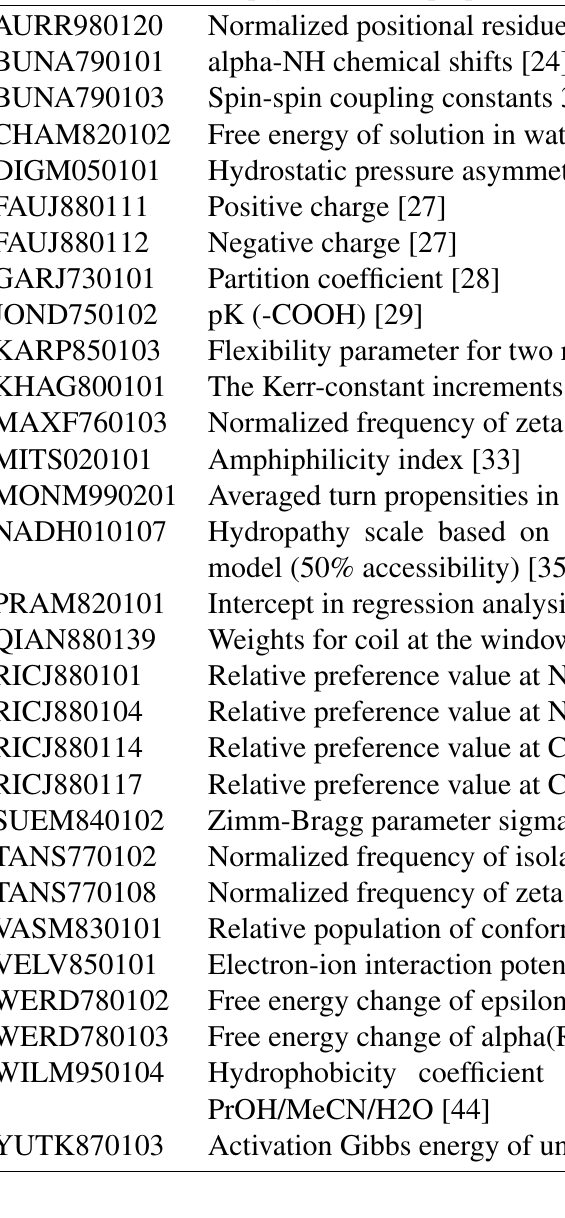
Table 1: The 30 physicochemical properties of amino acids considered from